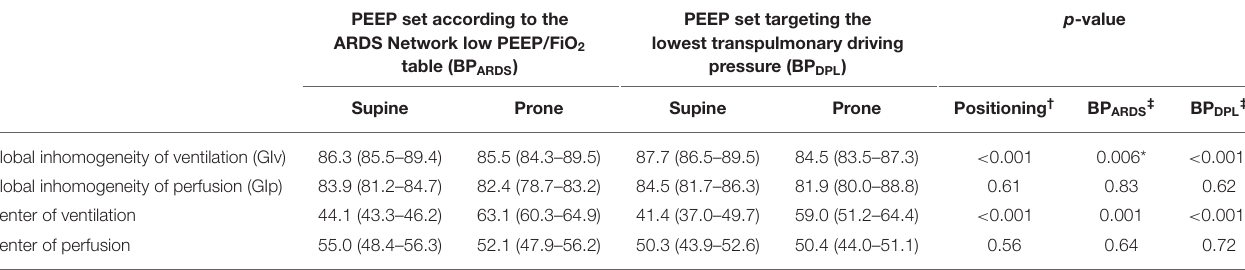
TABLE 3 | Electrical impedance tomography global lung ventilation and perfusion data.